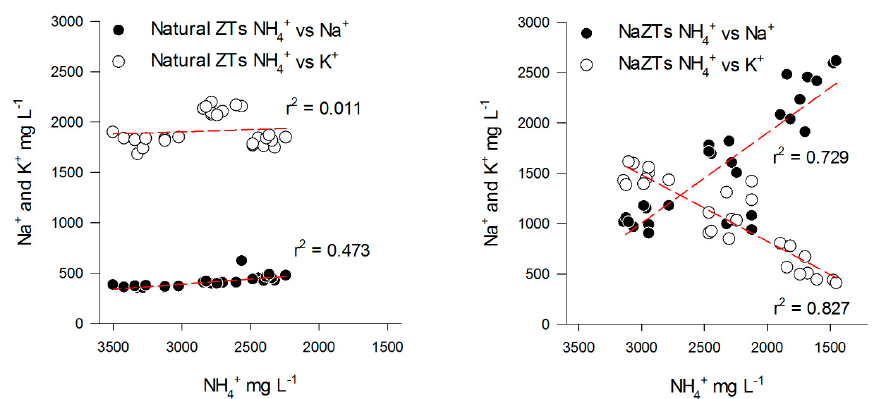
Figure 4. Relationships between Na + vs. NH 4+ (black dots) and K + vs. NH 4+ (white dots) in the samples treated with NaZTs (all the grain sizes together). Red dotted lines represent linear regressions.